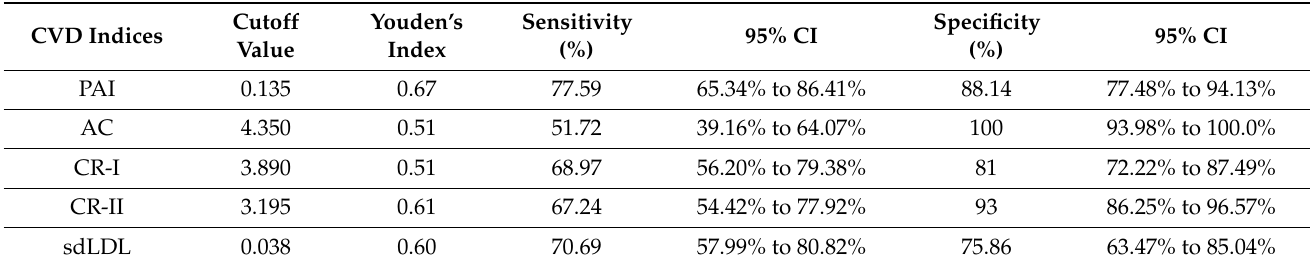
Table 3. Cutoff values at the optimum Youden’s index for different atherogenic indices and for plasma